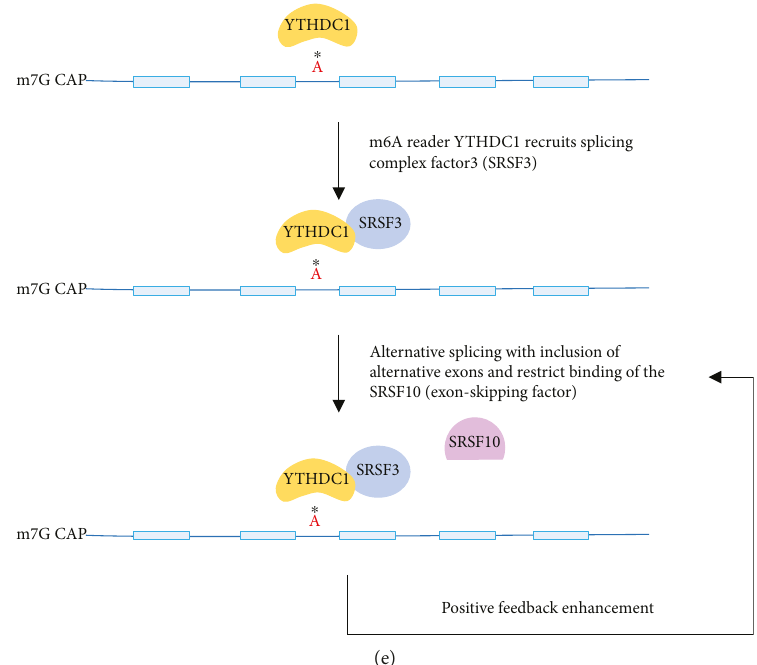
Figure 2: Dynamic regulation of RNA m6A levels by the m6A processing machinery and the known functions of m6A in regulation of RNA metabolism. (a) The coordination between m6A writers and m6A erasers maintains the m6A levels in accordance with the physiological conditions and the development and growth stages. (b) m6A reader hnRNP-A2/B1 mediated microRNA processing. The hypothesis